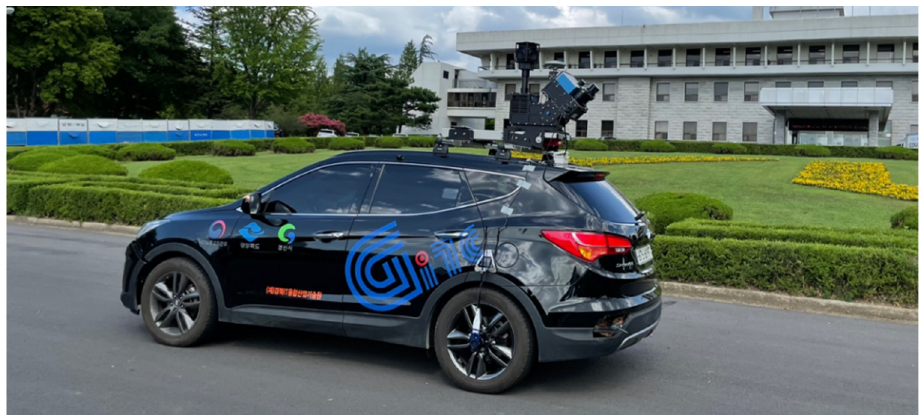
Figure 3. Driving the vehicle with the MMS.